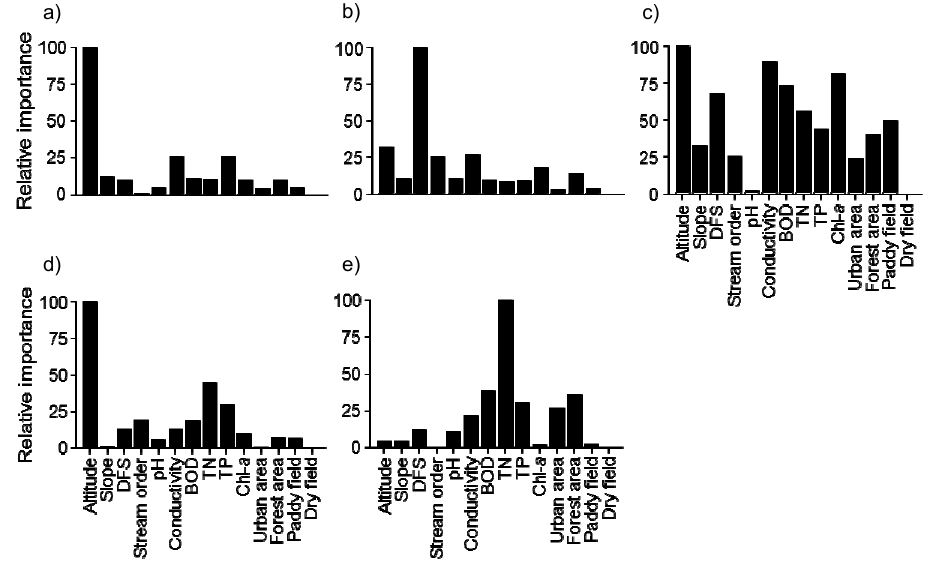
Figure 7. Importance of environmental variables in each cluster defined in SOM using a random forest